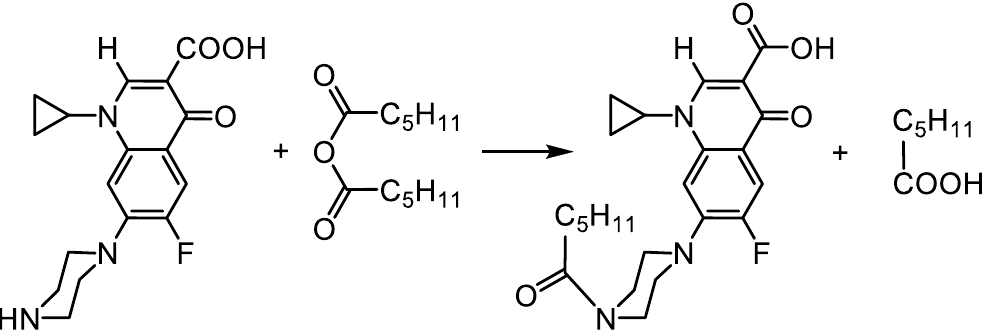
Figure 3. Synthetic strategy for the preparation of CPF-hex.